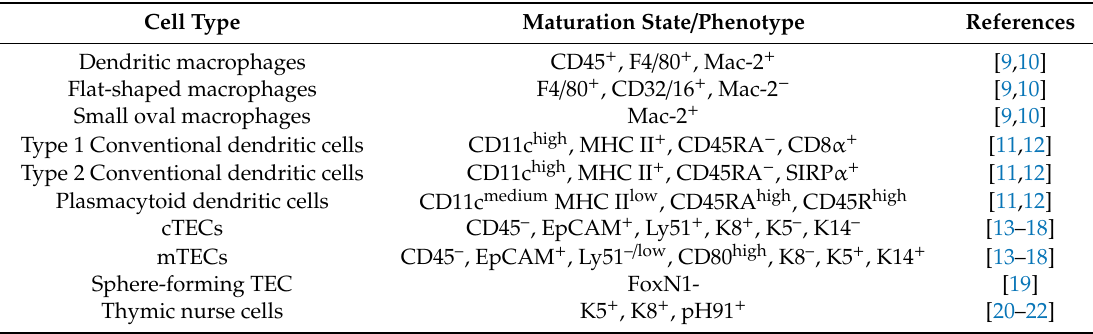
Table 1. Thymus parenchymal populations.